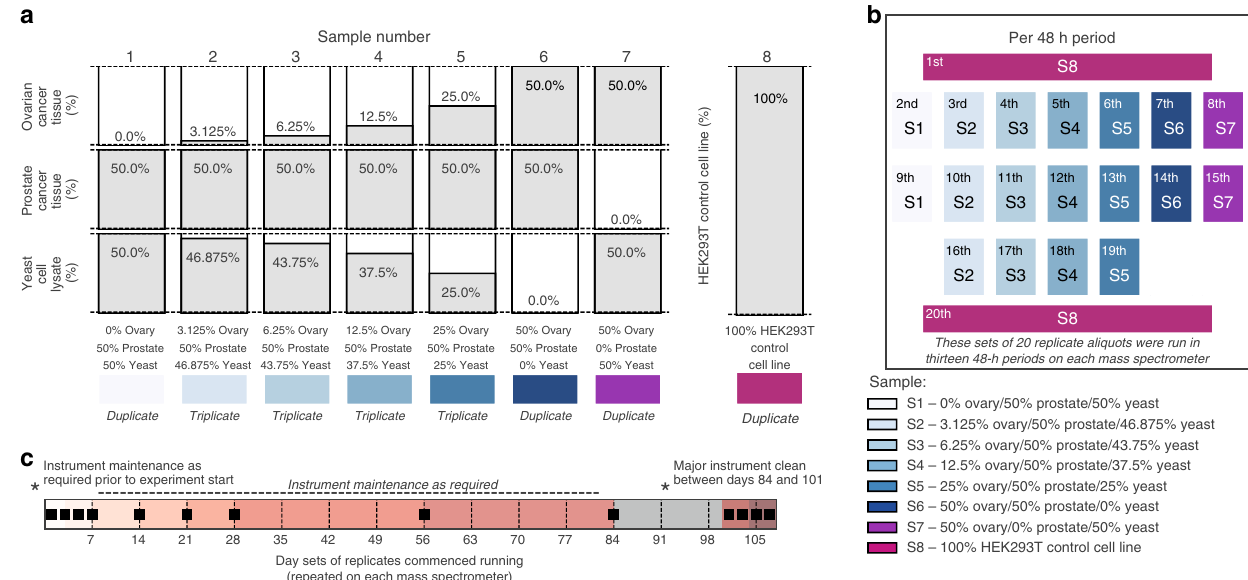
Fig. 1 Study design. a Composition of the eight samples analysed repeatedly throughout the study. b Twenty mass spectrometry runs during thirteen 48-h periods on each of six instruments. Each run is represented by a coloured panel corresponding to each of the eight samples (labelled S1 – S8), with the run order indicated in the upper left corner. Four samples were run in duplicate and four in triplicate during each 48-h period. c Mass spectrometer scheduling. Days on which 48-h periods of data collection commenced are indicated with a black bar, and the intended instrument cleaning schedule is also and negligible instrument batch effects (Fig. 2a). Without data